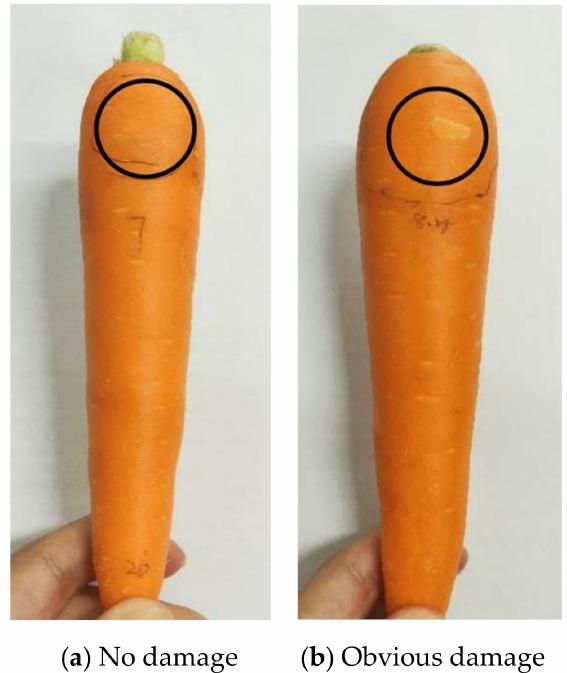
Figure 8. Damage status of